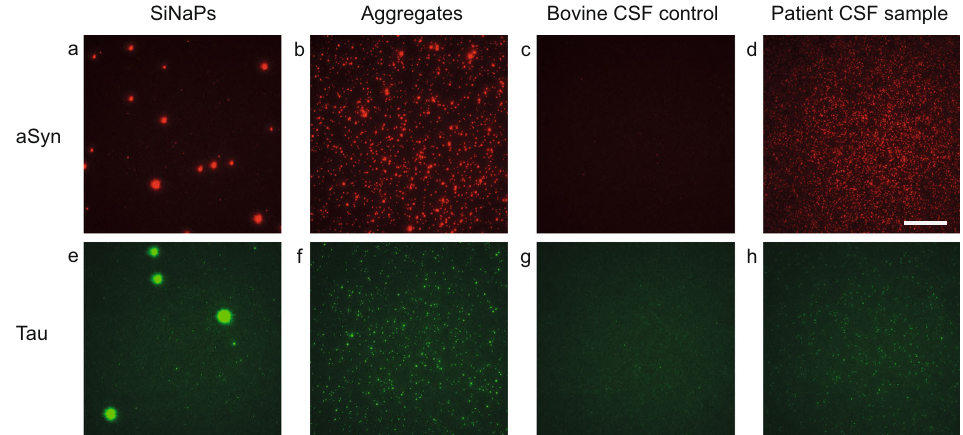
Fig. 2 TIRFM images of aSyn and Tau SiNaPs, synthetic aggregates, and samples. Shown are characteristic TIRFM images for the red fl uorescence channel (211 CF633) of a 629 fM aSyn SiNaPs in buffer, b 8 nM aSyn aggregates in buffer (the concentration is based on the monomer concentration), c a bovine CSF control, d a CSF sample of a PD patient as well as for the green fl uorescence channel (Tau5 CF488) of e 645 fM Tau SiNaPs in buffer, f 200 nM Tau aggregates in buffer (the concentration is based on the monomer concentration), g a bovine CSF control, h a CSF sample of a PSP patient. The scale bar is 25 µm. For illustration of the 14-bit images, the contrast was adjusted to a maximum grayscale value of